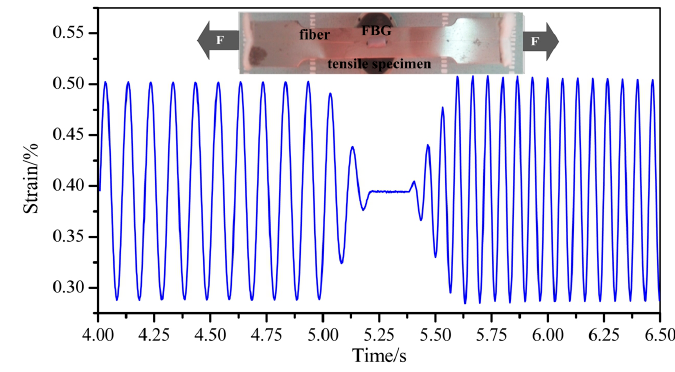
Figure 9. Dynamic strain measurements at 10 Hz and 15 Hz.